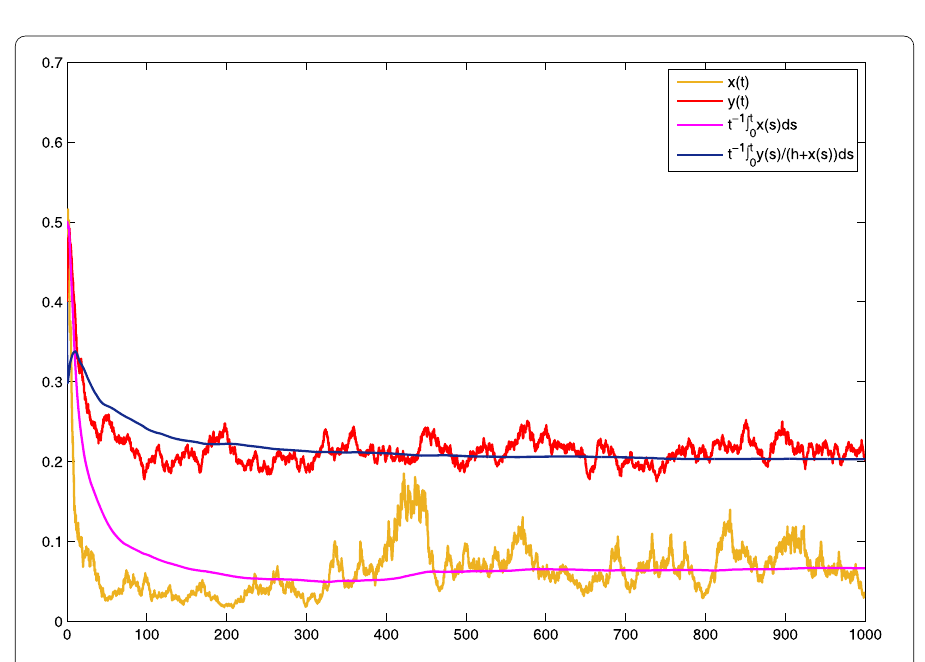
Figure 4 Solutions of model (3) with r 1 = 0.6, r 2 = 0.4, r 10 = 0.3, r 20 = 0.2, ξ 2 1 = 1.43, ξ 2 2 = 0.63, a = 0.4, c = 0.36, f = 0.25, h = 1. With α 1 = 0.715, α 2 = 0.7875